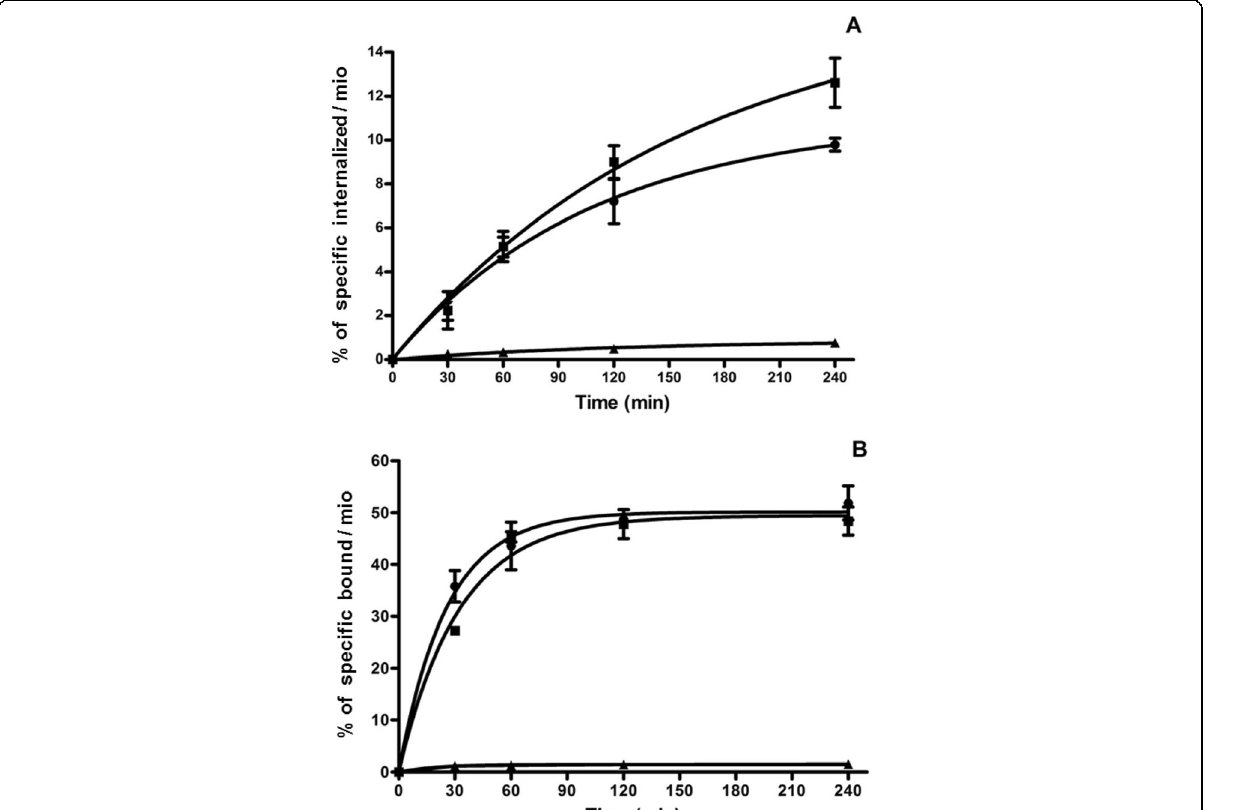
Fig. 3 In vitro cellular uptake profile of the radioligands on HEK293-rsst2 cells. Cellular uptake profile of 177 Lu-SS-03 (circle), 99m Tc-SS-04 (square), and 99m Tc-SS-05 (triangle) as measured with HEK293-rsst2 cells. a The amount of specifically internalised and b radiopeptides specifically bound to the membrane. Values and standard deviations are the result of two independent experiments with triplicates in each experiment